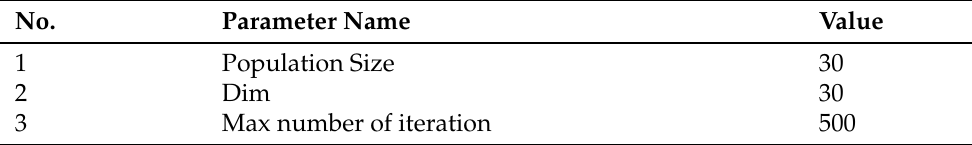
Table 2. Experiments parameters settings.